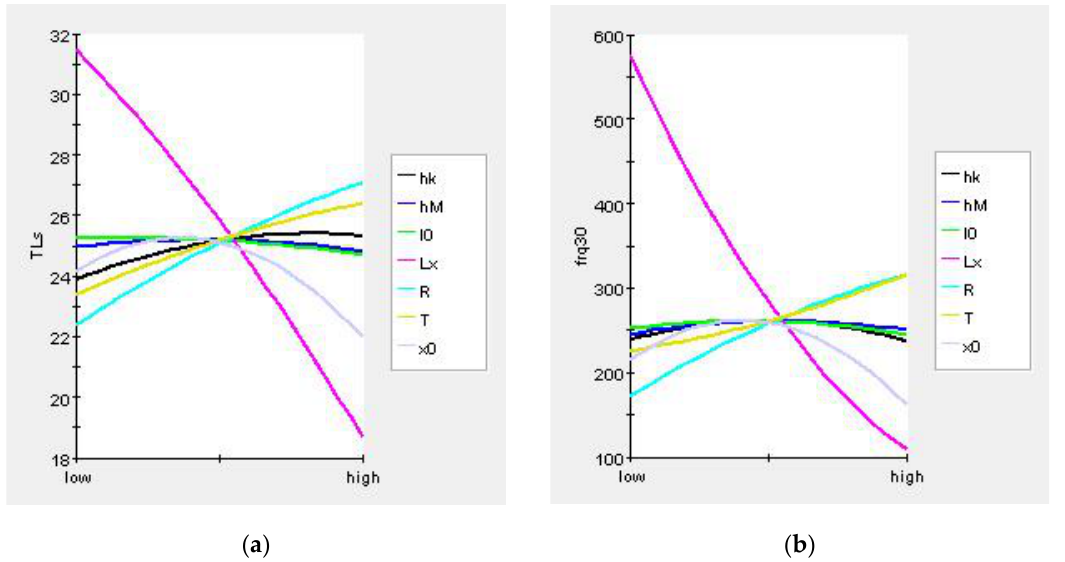
Figure 14. Main effect graphs of the optimization objectives: ( a ) TLs and ( b ) frq 30 .